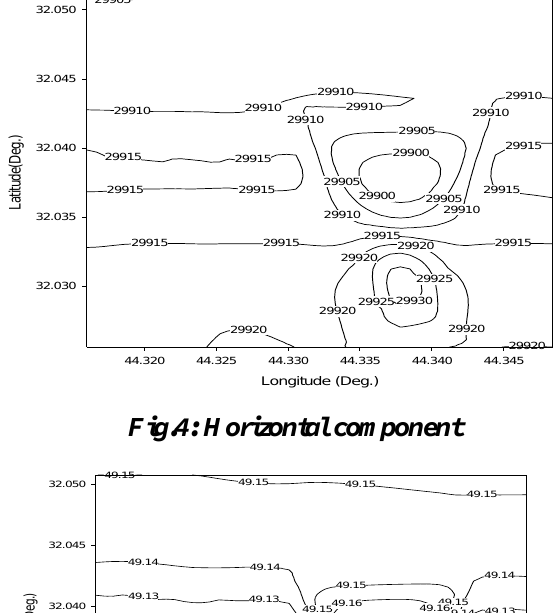
Fig.4: Horizontal component